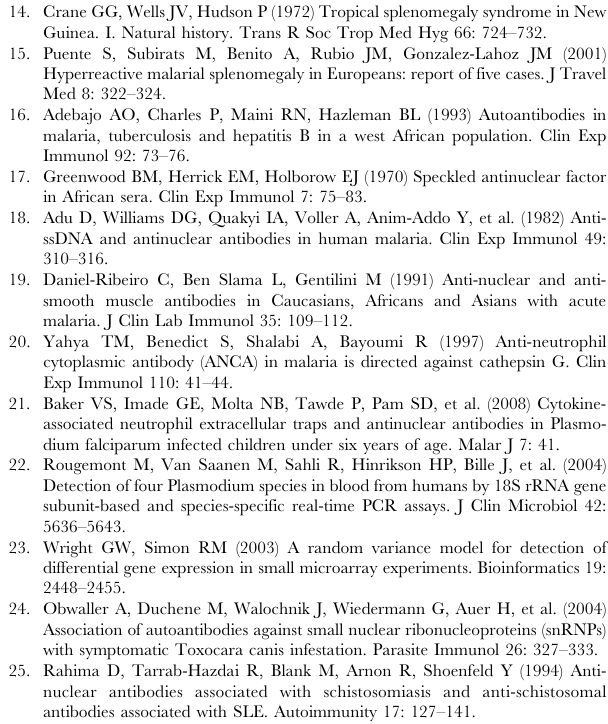
Figure S1 Presence of nuclear speckled and cytoplasmic diffuse pattern with perinuclear enhancement detected by indirect immunofluorescence on neutrophils in patients with malaria. Presence of nuclear speckled and cytoplasmic diffuse pattern with perinuclear enhancement detect- ed by indirect immunofluoresence on HEp-2000 TM cells (left) and corresponding fluorescence on human neutrophils fixed with ethanol (right). Representative results of five patients are shown.